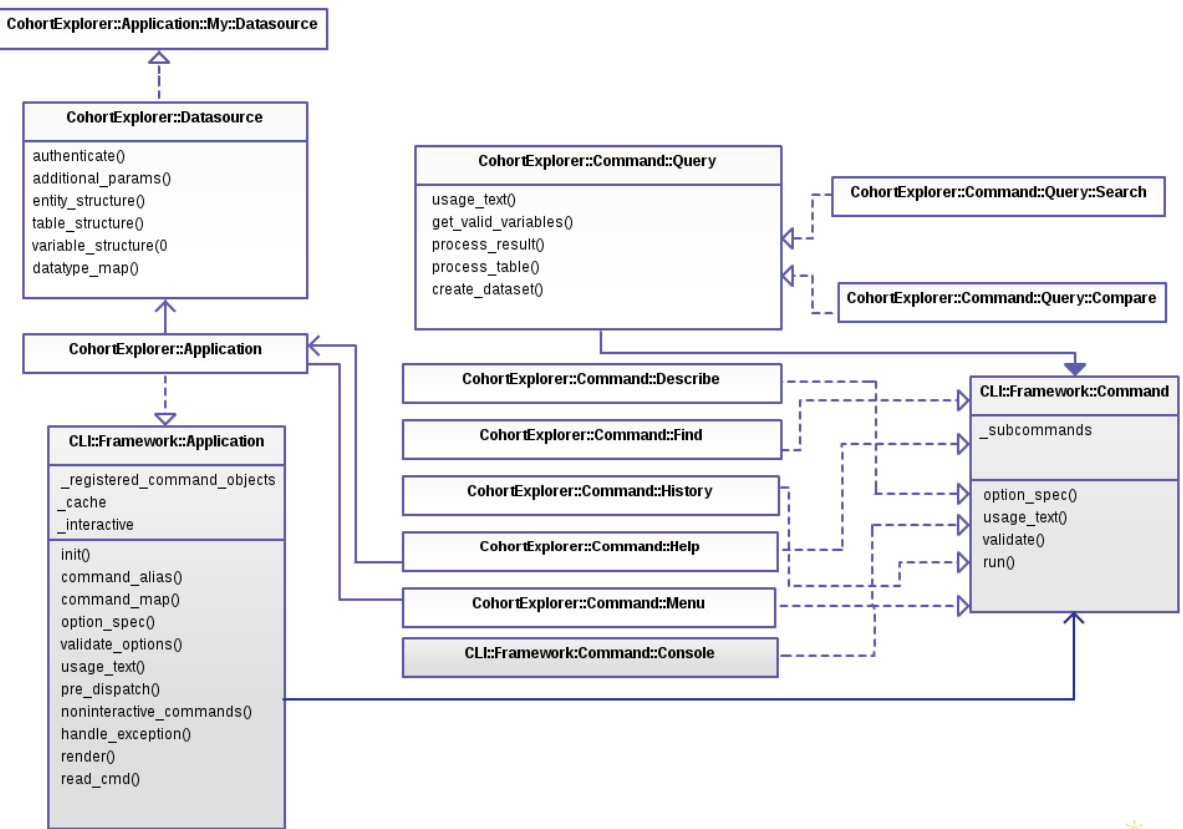
Figure 2. The figure shows the classes implemented under CohortExplorer. CohortExplorer::Application is inherited from CLI::Framework::Application (super class) and overrides the methods shown. All command classes are inherited from CLI::Framework::Command which is an abstract factory (dotted arrows). The meta commands such as menu and help are application aware commands with direct access to the application object. The application class dispatches the command objects. CohortExplorer::Command::Query extends CLI::Framework::Command (dark head arrow) and acts as an interface to search and compare command classes. CohortExplorer::Application class uses CohortExplorer::Datasource (an abstract class) to initialize the datasource. CohortExplorer::Datasource provides hooks or methods (also shown) which are implemented by subclasses such as CohortExplorer::Application::My::Datasource corresponding to electronic data capture and management systems such as Opal and